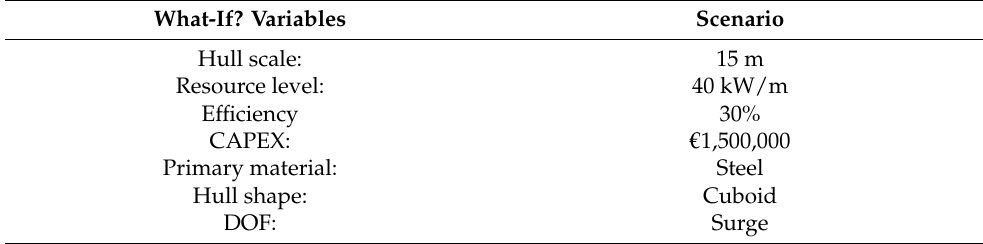
Table 3. Example of a scenario comprised of values for the what-if? variables.